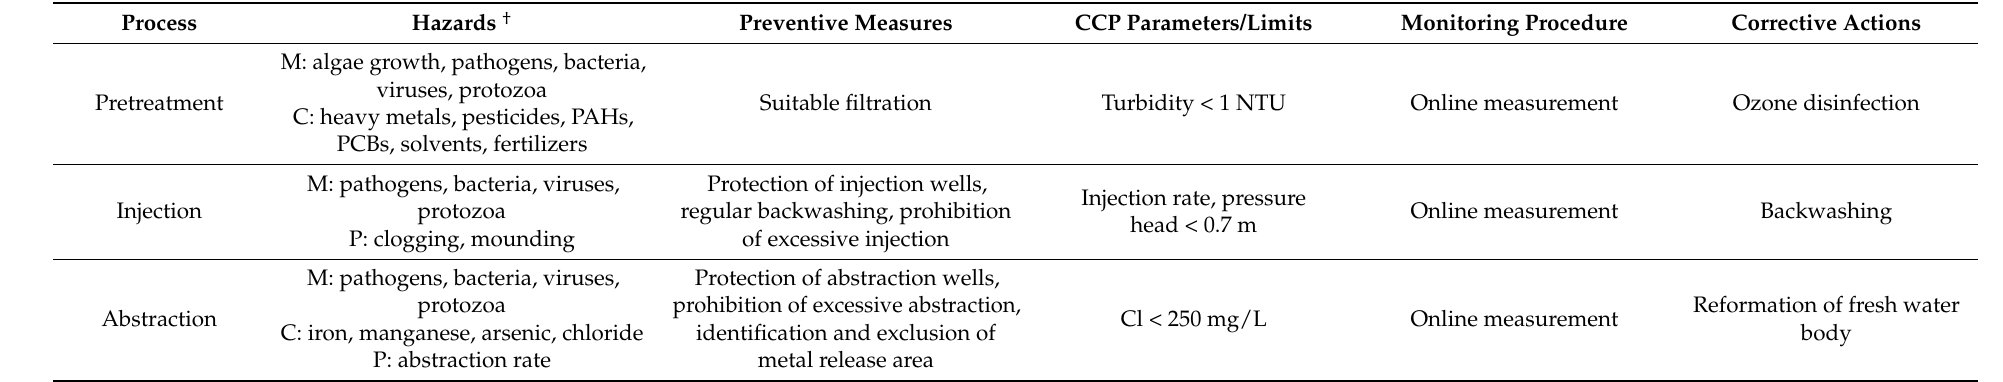
Table 6. CCP management guidelines for the combined ASTR and HACCP process (modified from